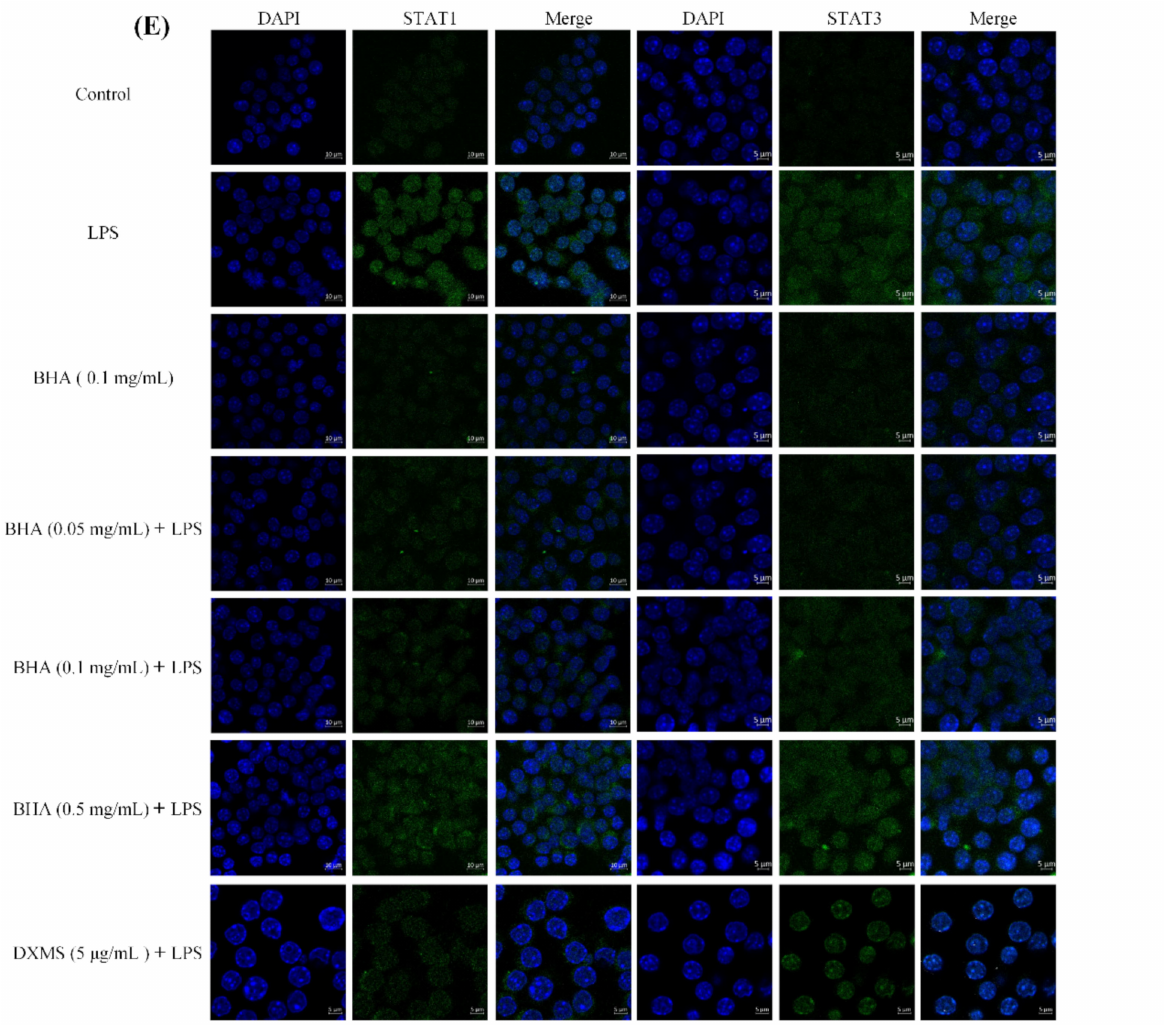
Figure 2. ( A ) Effects of BHA on the viability of RAW264.7 cells. Cells were incubated with BHA (0.01, 0.05, 0.1, 0.25, 0.5 or 1 mg/mL) for 6 and 24 h. Cell viability was measured using MTT assays. Data are presented as the mean ± SEM of three independent experiments. ( B – D ) Validation of the anti-inflammatory effects of BHA on LPS-induced RAW264.7 macrophage cells. Cells were pre-treated with various concentrations of BHA for 6 h and stimulated with 1 µ g/mL of LPS for 12 h. Supernatants were collected after LPS stimulation, and the protein levels of TNF α , IL-1 β and IL-6 were quantified by corresponding ELISA kits. Data are presented as the mean ± SEM of three independent experiments. ( E ) The expressions of STAT1 and STAT3 were detected by confocal laser microscopy. Cells were fixed, permeabilized and then incubated with anti-STAT1 and STAT3 antibodies followed by the incubation with FITC conjugated anti-rabbit IgG antibody (green). The nuclei were stained with DAPI (blue). Scale bar = 5 µ m. One-way ANOVA was used to compare the results between each group. * p < 0.05, ** p < 0.01, *** p < 0.001, **** p < 0.0001. * Compared with the untreated LPS-induced model